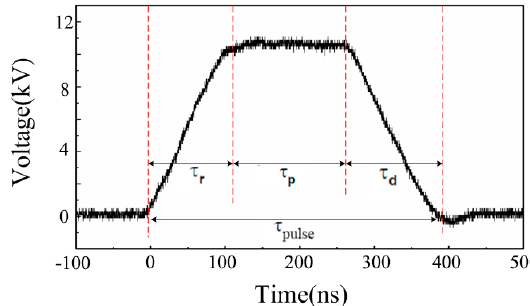
τ τ , plateau time p and τ r τ , plateau time p and r